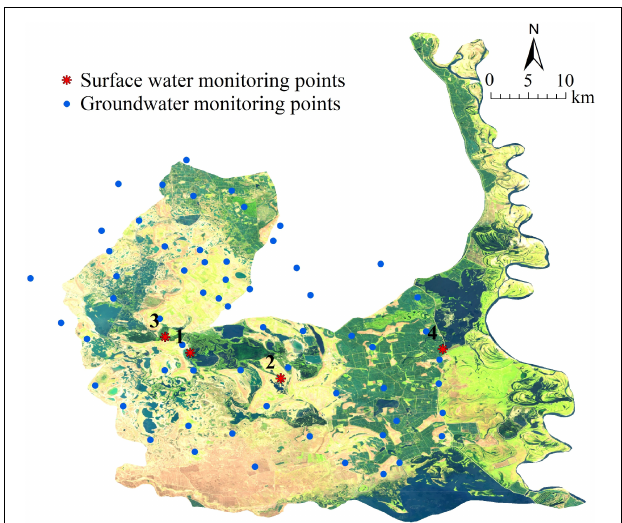
FIGURE 2 | Distribution of surface water level loggers and groundwater table monitoring sites (Image source: Landsat 8TM band 654 false-color combination, imaging date: June 20,